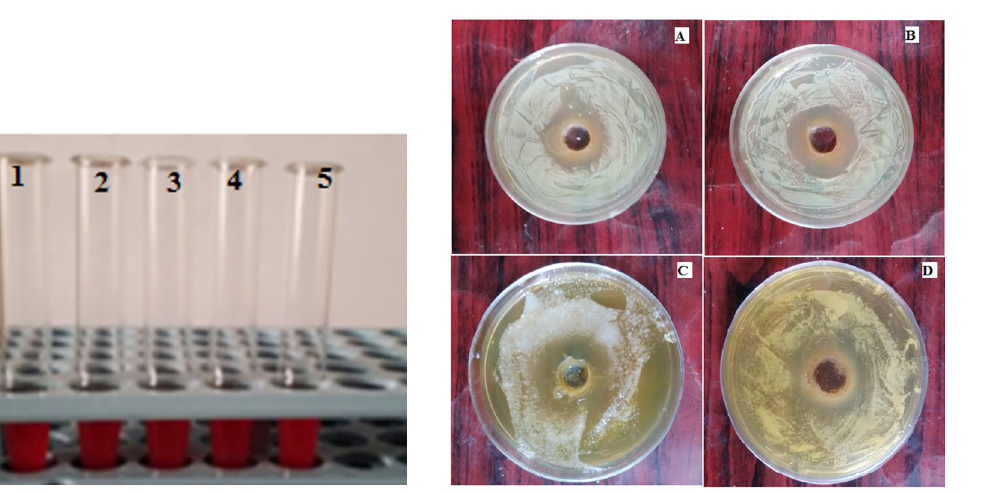
Fig. 1. A full scan of the IR spectrum of alkaloid